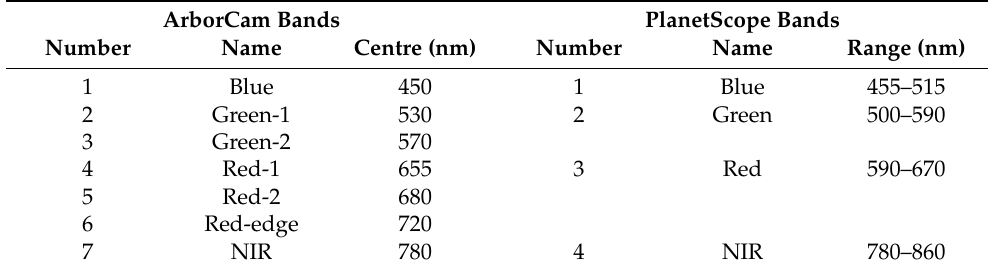
Table 2. Band numbers, names, and regions of the ArborCam sensor and PlanetScope sensors